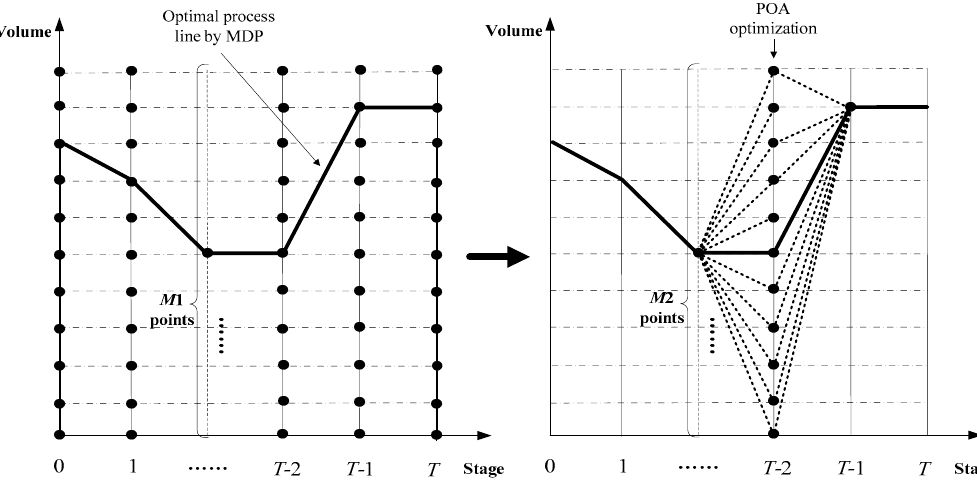
Figure 2. Initial operation trajectories derivation and its further optimization by the Progressive Optimality Algorithm (POA) in MDP-POA.